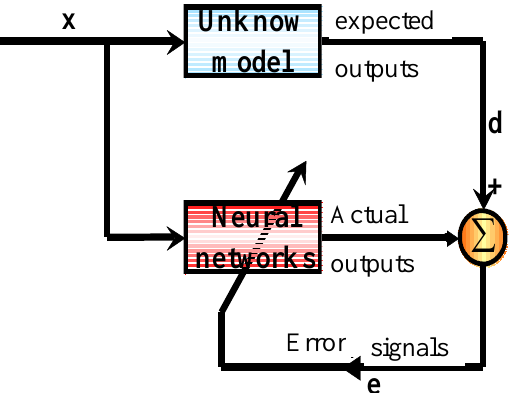
Figure 9. Supervised learning for function